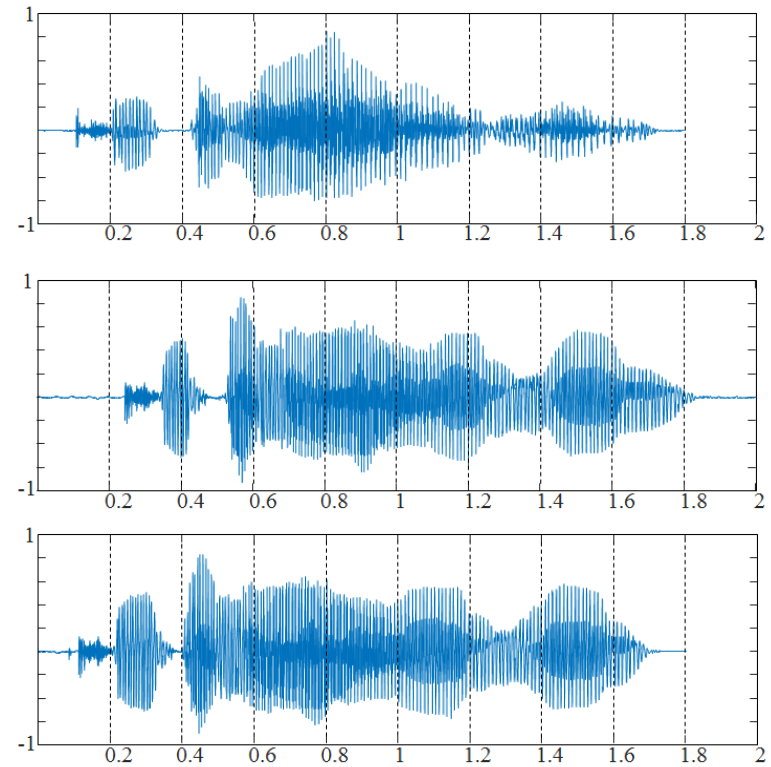
Figure 2. Examples of the time-aligned waveforms. Top: Reference speech. Middle: Target speech. Bottom: Time-aligned target